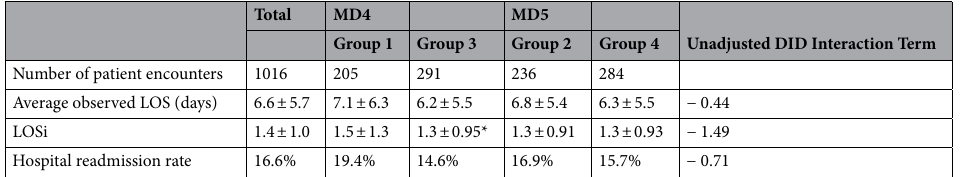
Table 5. Observed LOS, LOSi, hospital readmission comparison and difference in difference results. *Denotes statistically significant difference ( p < 0.05) in LOS Index for comparison between Group 1 and Group.